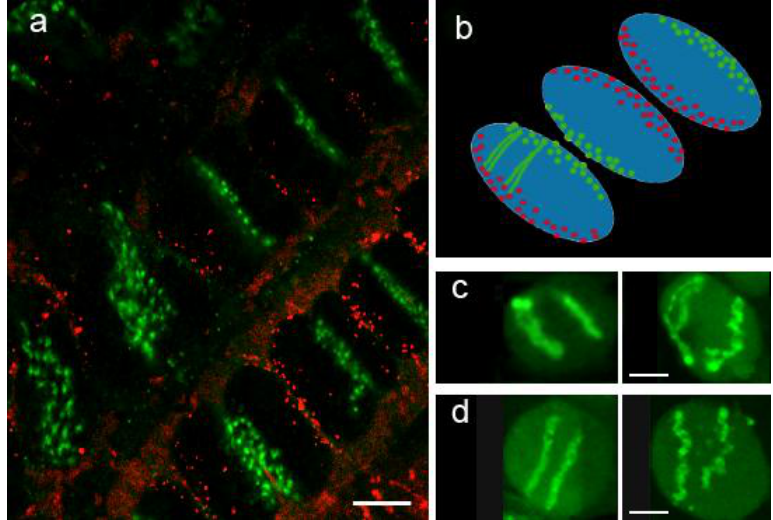
Figure 2. Rabl chromosome organization in wheat root tissue. ( a ) Centromeres (green) and telomeres (red) are labelled by fluorescence in situ hybridization (FISH) and are located at opposite sides of the nuclei; ( b ) Diagrammatic interpretation of the organization in ( a ); ( c ) Introgressed pair of rye chromosomes in wheat labelled by genomic in situ hybridization (GISH) with total rye genomic probe confirms a Rabl organization of individual CTs. ( d ) Single rye arm translocation into wheat localized by GISH. In ( c ) and ( d ) the RH panel in each case shows a nucleus from a seedling treated with 5-AC, whereas the LH panel shows a control untreated seedling. The 5-AC treatment has disrupted the CT organization, but the CTs remain in a Rabl configuration. Bar = 10